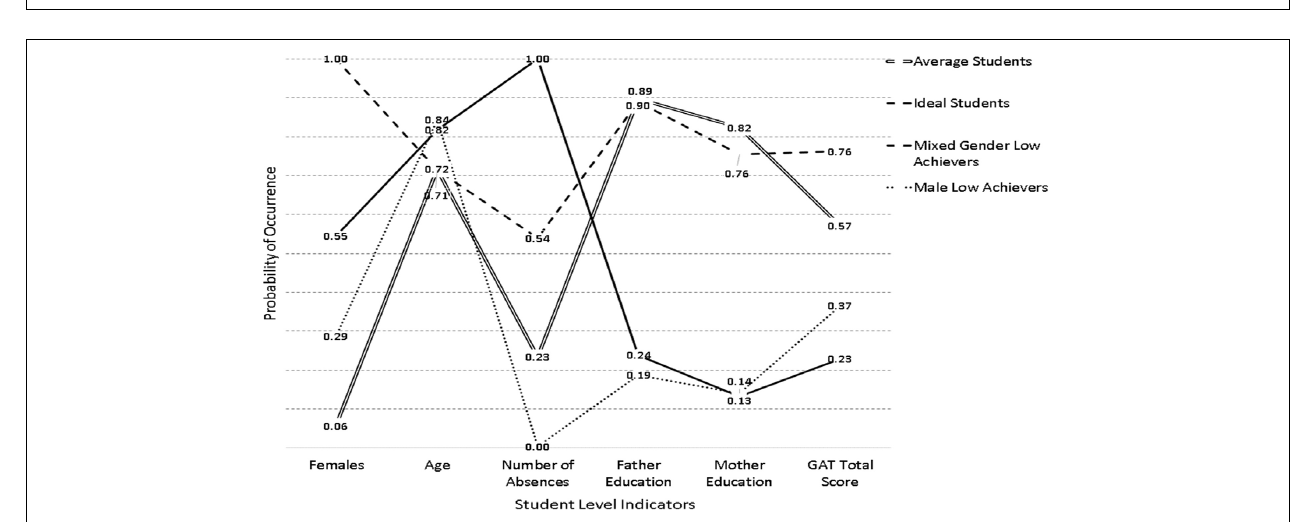
FIGURE 3 | Latent class solutions in the year